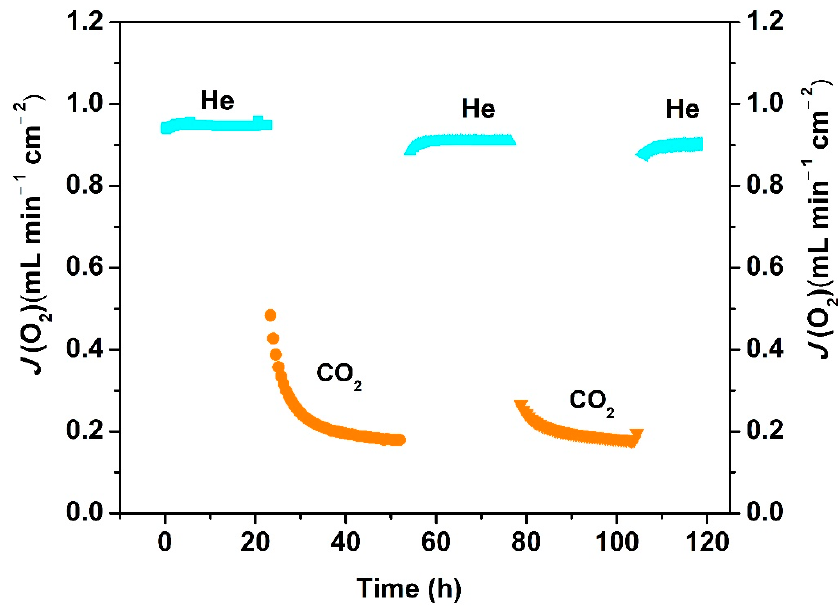
Figure 10. Long-term oxygen permeation flux through a Ce 0.9 Pr 0.1 O 2 − δ –Nd 0.5 Sr 0.5 Fe 0.9 Cu 0.1 O 3 − δ membrane at 1223 K under an air/He or air/CO 2 gradient. Test conditions: 0.65 mm membrane thickness; 150 mL min − 1 synthetic air as the feed gas; 29 mL min − 1 CO 2 as the sweep gas; 1 mL min − 1 Ne as an internal standard gas. Membranes 2020 , 10 , 8